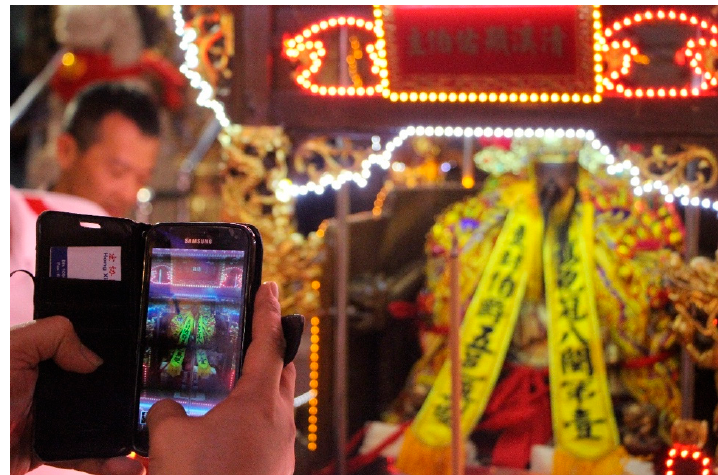
Figure 8. A Devotee Reproduces an Image of Anxi Cheng Huang Ye. (Source: Alvin Eng Hui Lim).